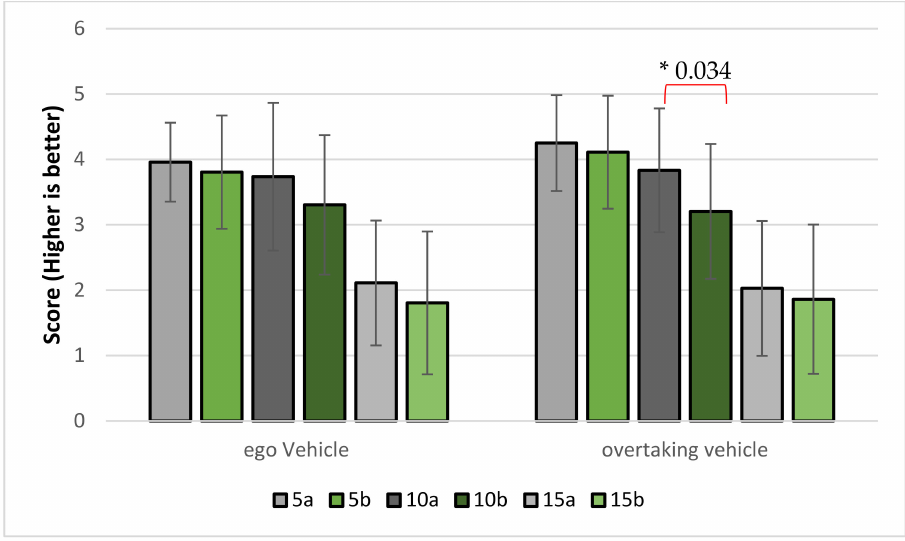
Figure 9. The average score for visibility (* represents the significance value <